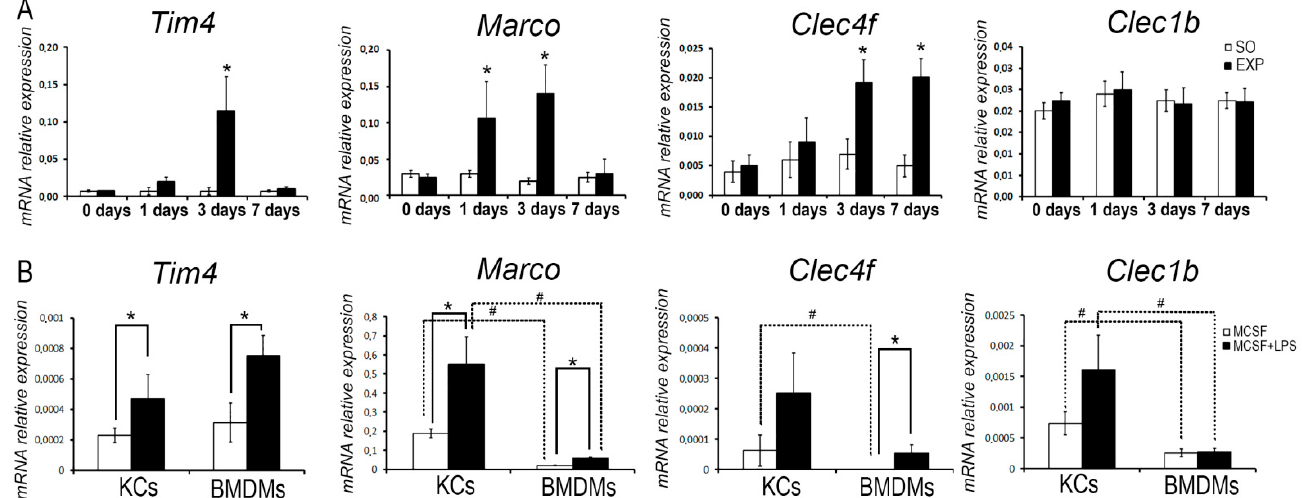
Figure 2. Expression of macrophage marker genes in regenerating livers ( A ) and in macrophages under the influence of LPS ( B ). ( A ). Expression of macrophage marker genes in regenerating liver studied by RT-PCR. ( B ) Expression of Marco , Tim4 , Clec4f , and Clec1b genes studied by RT-PCR in bone marrow-derived macrophages (BMDMs) and Kupffer cells (KCs). The data are presented as means ± standard deviations, with at least five specimens studied for each time-point after the resection. EXP—hepatectomized mice, SO—sham-operated mice, *, # —the statistical significance of the differences with sham-operated control or corresponding group ( p < 0.05).